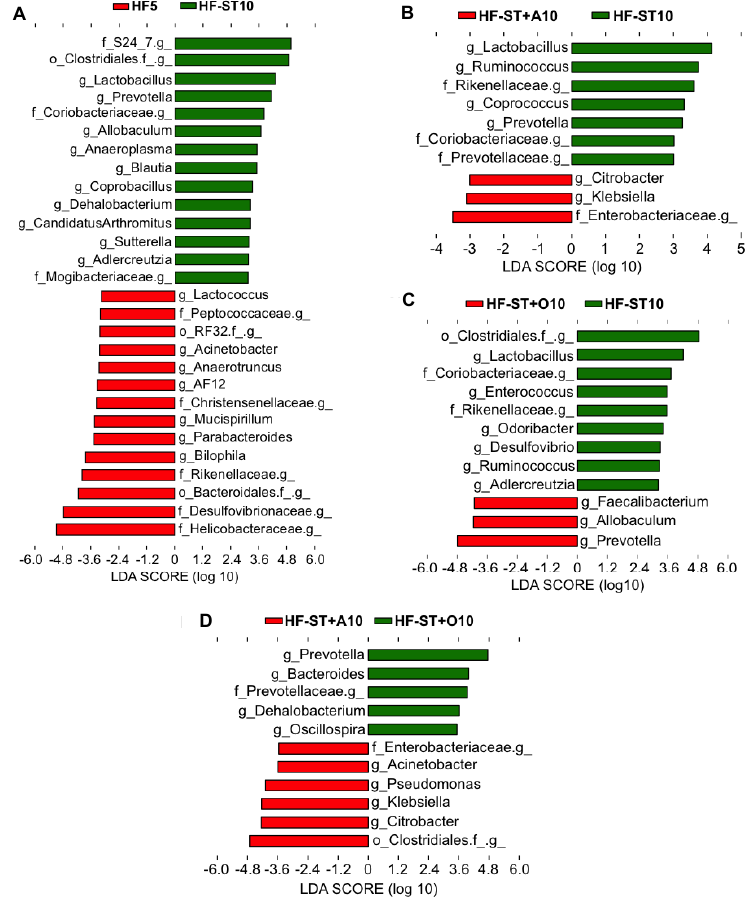
Figure 4. Linear discriminant analysis showing the differentially-overrepresented genera between overweight mice fed with: a high-fat diet and the diet shift ( A ); the diet shift and agavins supplement ( B ); the diet shift and oligofructose supplement ( C ); and agavins and oligofructose supplements ( D ). LDA effect size (3.0-fold) was used to determine the significant